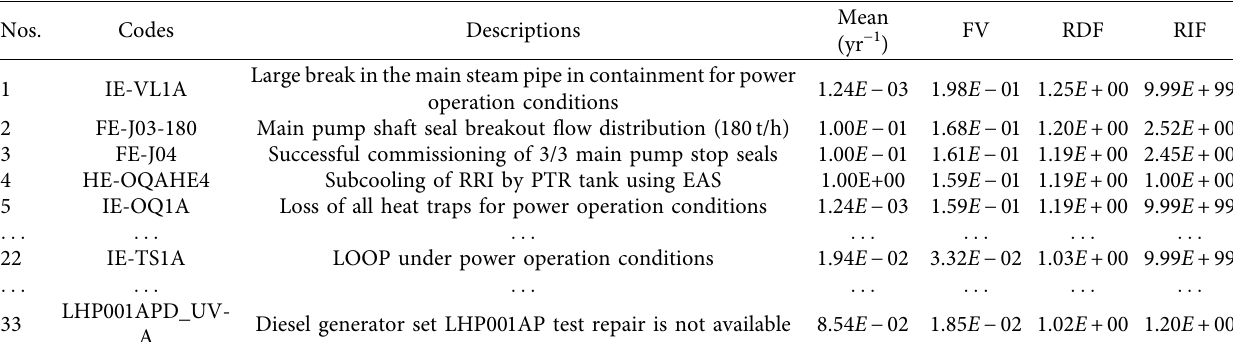
Table 3: Classifcation of the basic event importance of CDF.